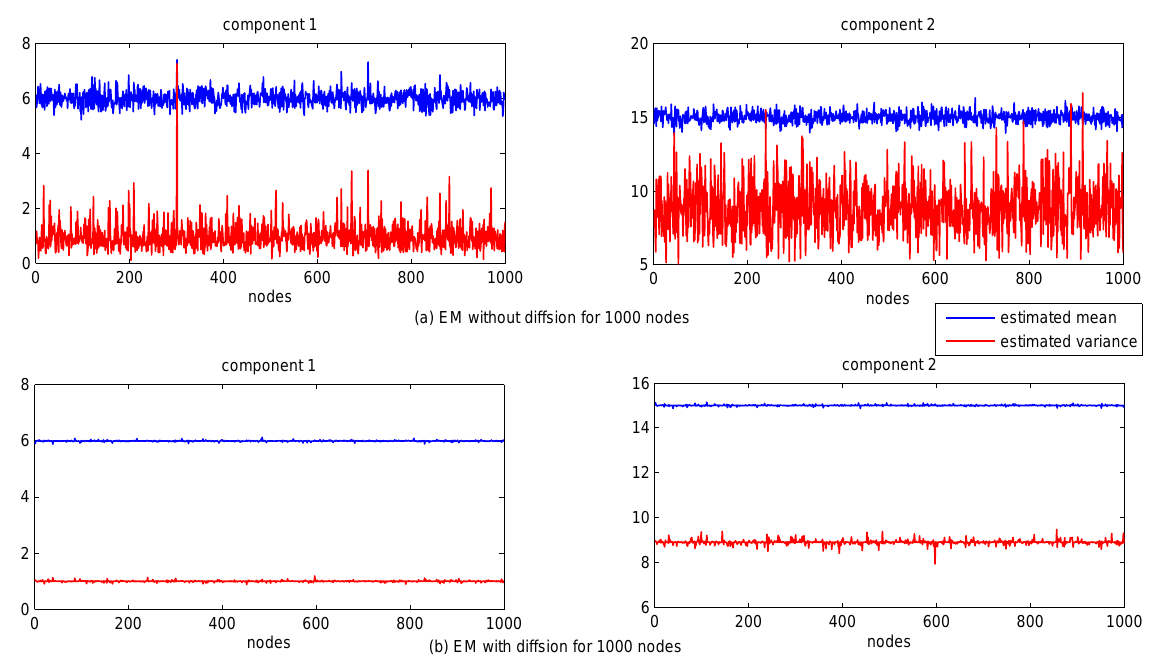
Figure 6. Estimated mean and covariance with and without diffusion.